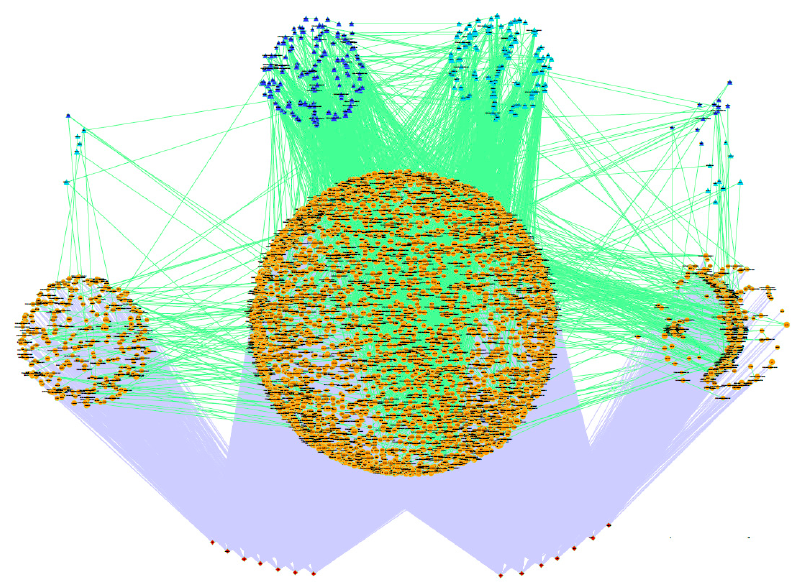
Figure 5. Co-association network between the 4585 genes selected by the stepwise procedure. This network includes all the transcription (TF: depicted in dark blue) and co-transcription factors (CF: depicted in light blue) and the rest of genes (painted in orange), together with the 14 traits analysed (described in red). The significant co-associations between the pair of genes and the significant association between a gene and trait were represented with an edge (Positive co-associations: green; GWAS association: Grey). The size of the nodes was based on the pleiotropic effect of the gene on the traits under study. This co-association network explained 2.4 times the total genetic variance.